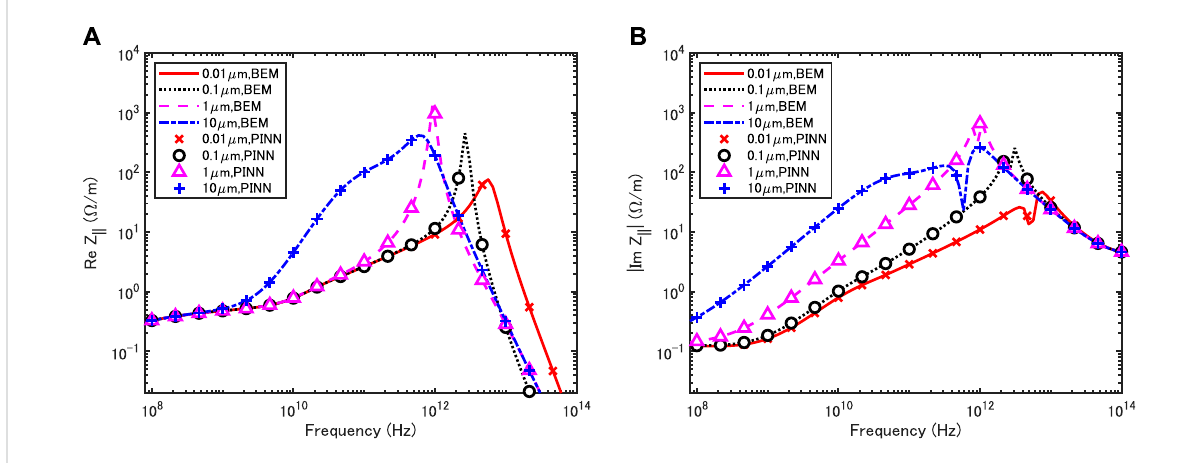
FIGURE 7 Coupling impedances of a round Gaussian beam with σ r = 0.5 mm moving on the axis of the circular vacuum chamber with the three-layer structure of copper (Cu), stainless steel (SS), nonevaporable getter (NEG). Real part (A) and imaginary part (B)